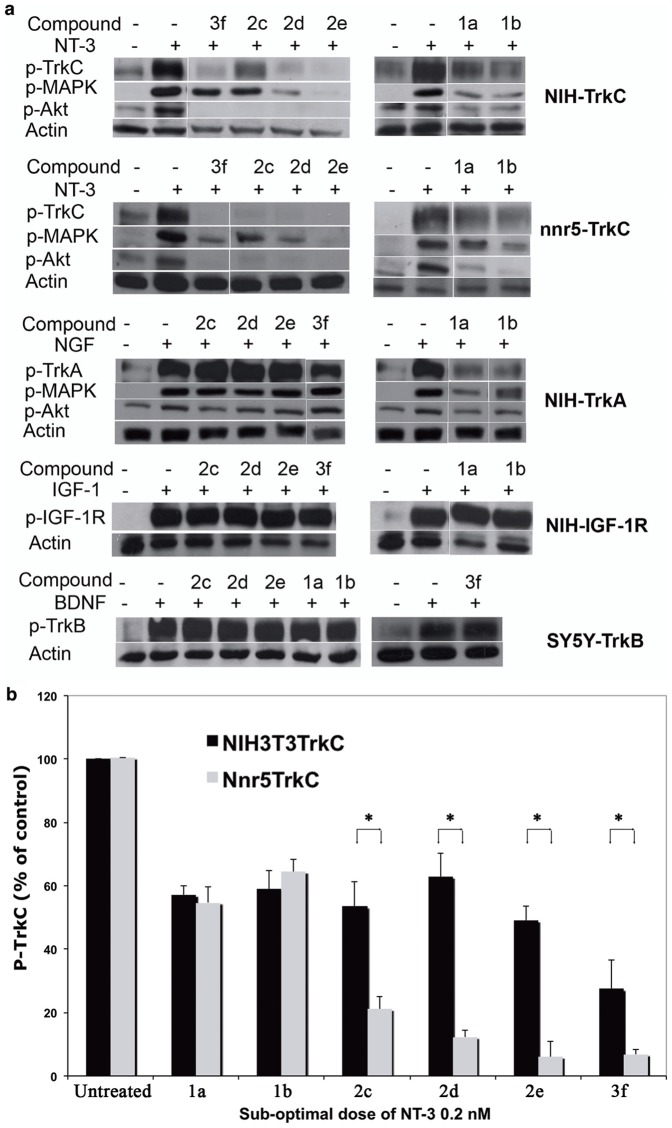
Antagonists of TrkC or TrkA receptor inhibit ligand-dependent signaling pathways in cell lines.(a) NIH-TrkC (a), nnr5-TrkC (b), NIH-TrkA (c), NIH-IGF-1R (d) and SY5Y-TrkB (e) cells were exposed to the indicated peptidomimetic (10 µM) and NT-3 (0.2 nM) (a, b), NGF (0.2 nM) (c), IGF-1 (10 nM) (d) and BDNF (0.2 nM) (e) for 20 min. Detergent lysates were analyzed by Western blotting with anti-pTyr mAb 4G10 or anti-phospho-MAPK or anti-phospho-Akt. After stripping, membrane was re-probed with anti-actin antibodies to standardize loading. (b) Quantification of p-TrkC in NIH-TrkC and nnr5-TrkC by densitometry from 3 independent experiments. Data are expressed as the mean + SEM relative to growth factor. One-way ANOVA, p<0.05 considered significant. All “hits” shown were significant for inhibition of TrkC compared versus drug-untreated. * indicates differences in efficacy comparing the two cell lines.